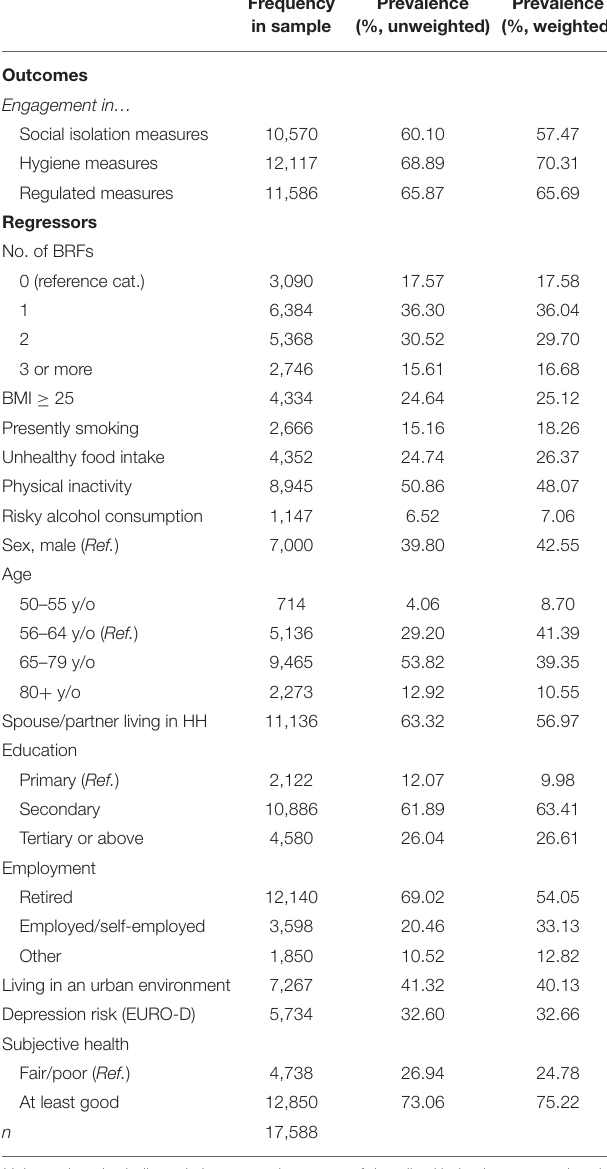
TABLE 2 | Descriptive statistics of the analytical sample for continuous variables. Mean